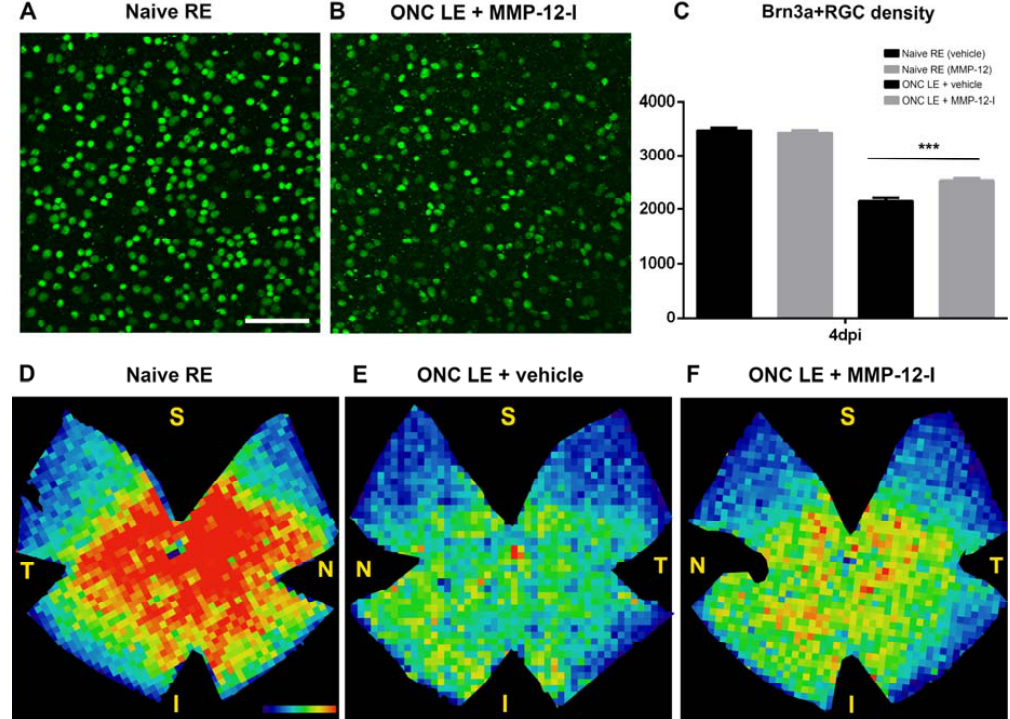
Figure 6. Effect of MMP-12 inhibition on retinal ganglion cell (RGC) survival and distribution after optic nerve crush (ONC). Immunohistochemical stainings for Brn3a on flat mounted retinas showing Brn3a + RGCs from a control ( A ) and an injured retina from the MMP-12 inhibitor-treated group 4 dpi ( B ). Both images illustrate the superotemporal medial retina. A decrease in the number of Brn3a + RGCs is observed after axonal lesion. ( C ) Bar graph of the Brn3+RGC density in whole mount retinas after ONC in vehicle and inhibitor-treated mice. At 4 dpi Brn3a + RGC survival is significantly higher in the MMP-12 inhibitor treated group compared to vehicle mice ( p < 0.001) for the injured left eye, with normal RGC counts for the normal right eye of both groups. Representative isodensity maps, generated by assigning a color according to the RGC density value, illustrate Brn3a + RGC from flat-mounted control, ( D ) and experimental retinas from vehicle ( E ) and treated ( F ) mice, and reveal the decreased number of surviving Brn3a + RGCs at 4 dpi. The control retina shows a normal density, with highest (red) density in the central and lowest (blue) within the peripheral retina. RGC loss after ONC was diffuse and affected the whole retina. A substantially stronger decrease in RGC density is observed in the vehicle only group retinas as compared to retinas of the inhibitor treated group. S, superior; N, nasal; T, temporal; I, inferior. Data are shown as mean ± SEM. n = 6–8. *** p < 0.001; Bonferroni post ‐ hoc test. Scale bar: 50 μ m.